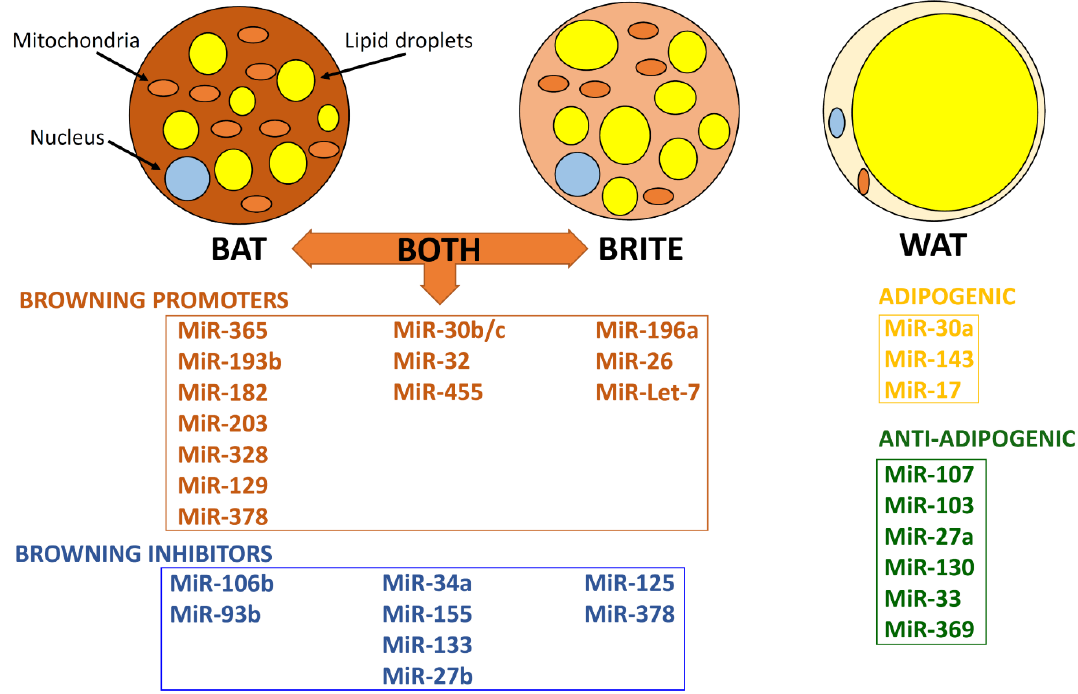
Figure 2. Key microRNAs (miRNAs) regulating brown adipose tissue (BAT), brite (beige or brown-in-white) adipose tissue, and white adipose tissue (WAT).